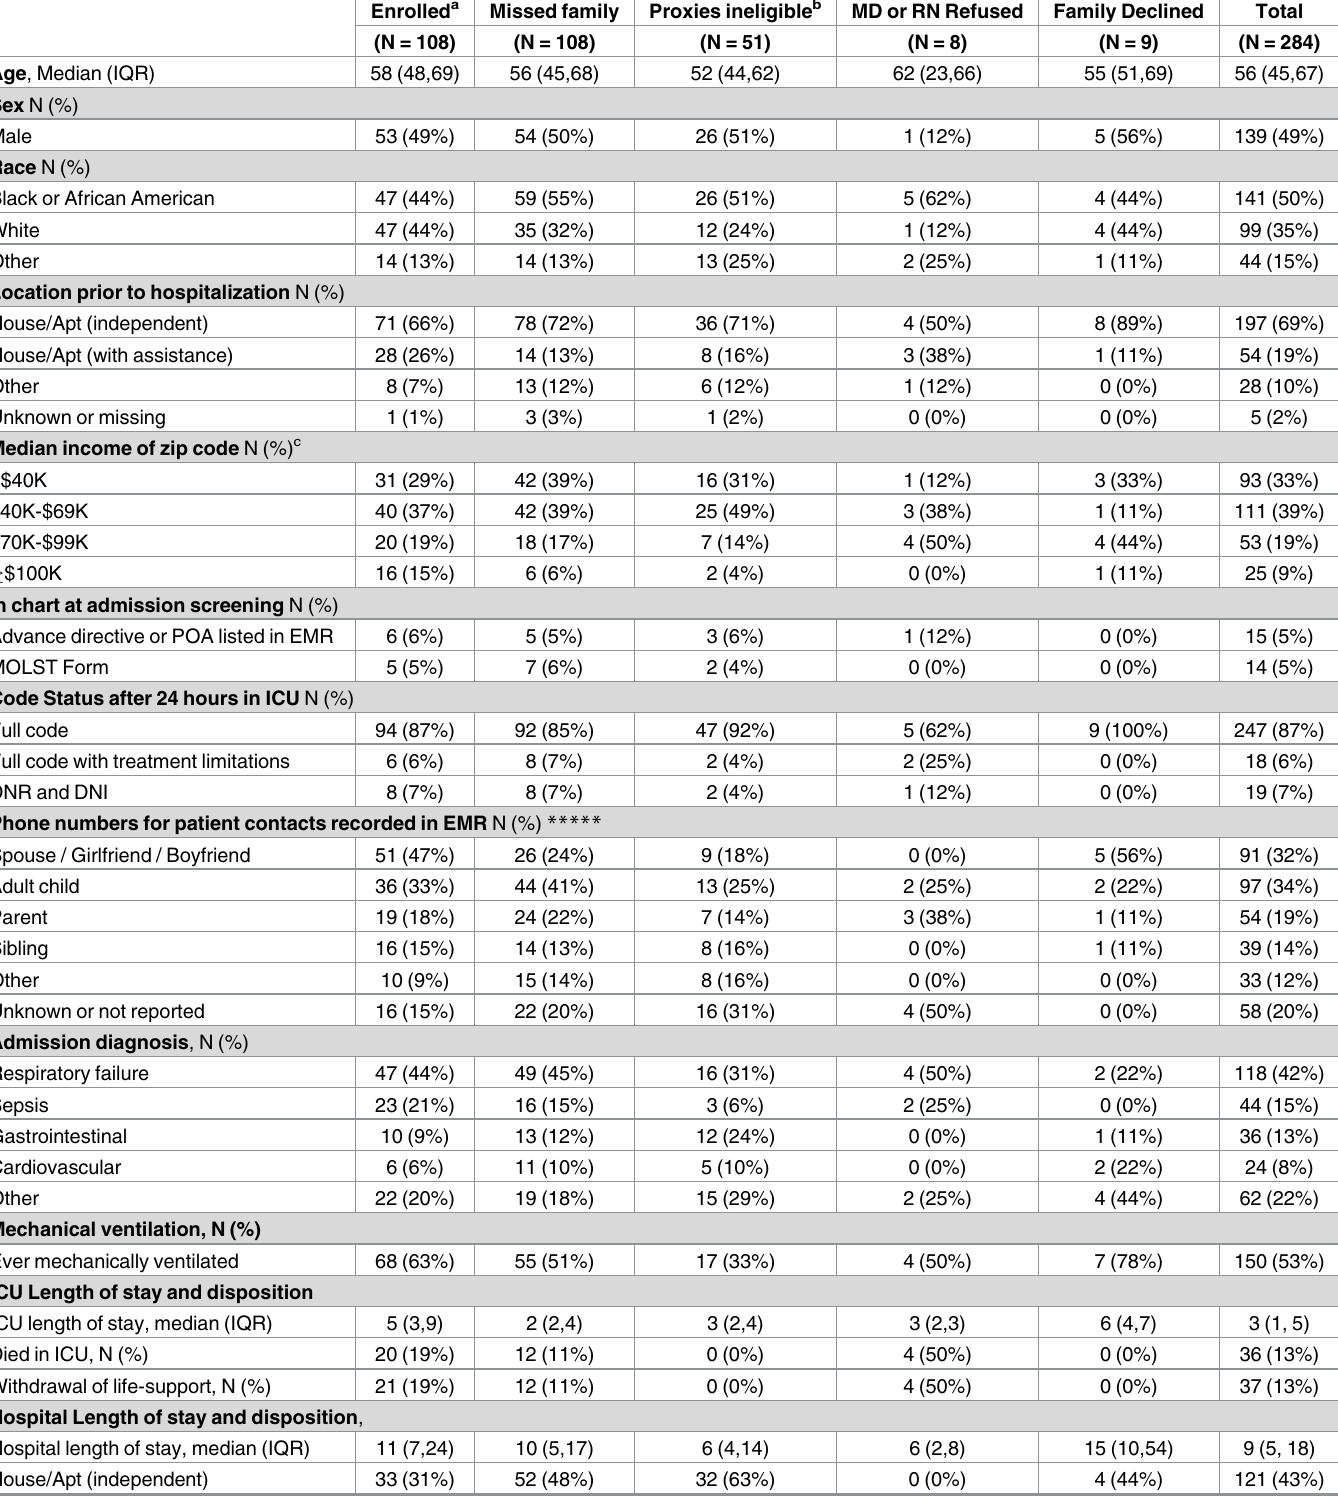
Table 1. Characteristics of eligible patients by enrollment